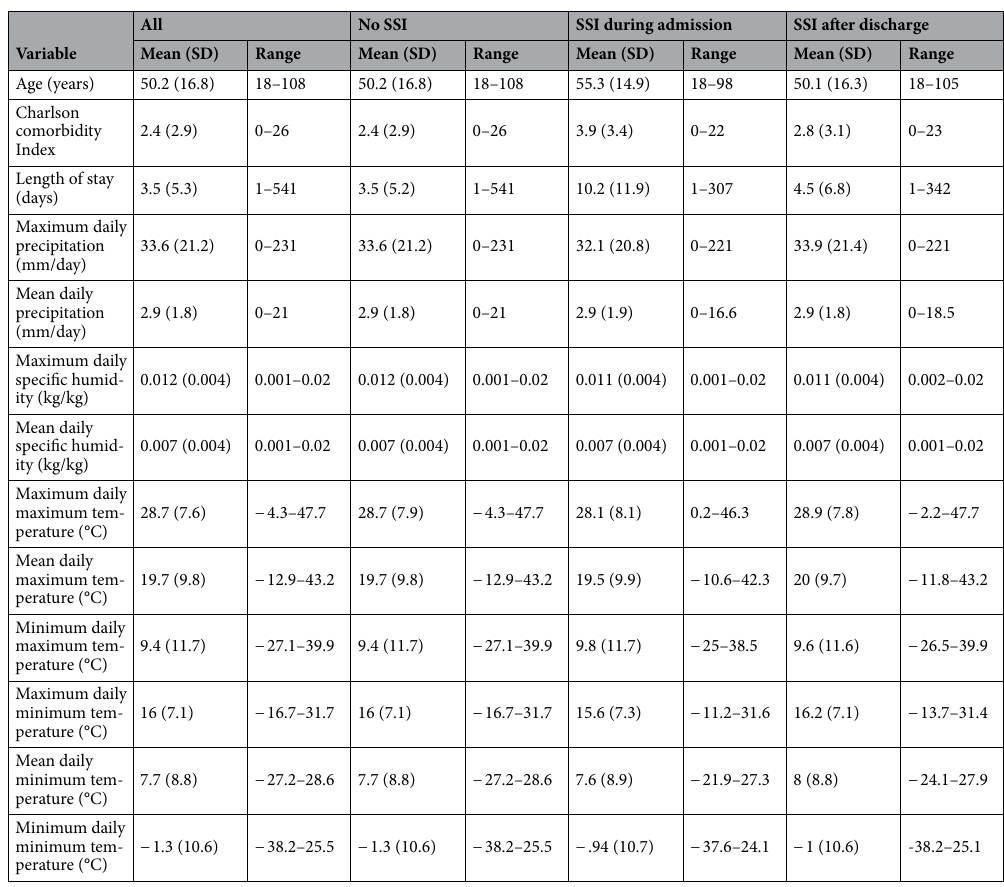
Table 2. Descriptive statistics of qualified MarketScan ® procedures records (n = 7,702,846). SSI: Surgical site infection.